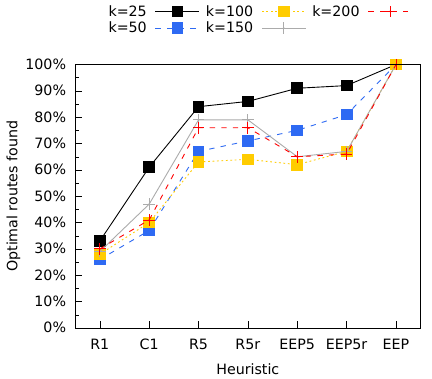
Figure 7: Optimal routes withinRosenheim , varying k